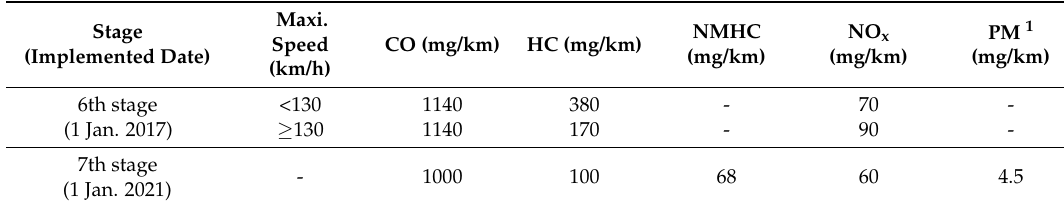
Table 1. Emission standards of motorcycles in Taiwan.